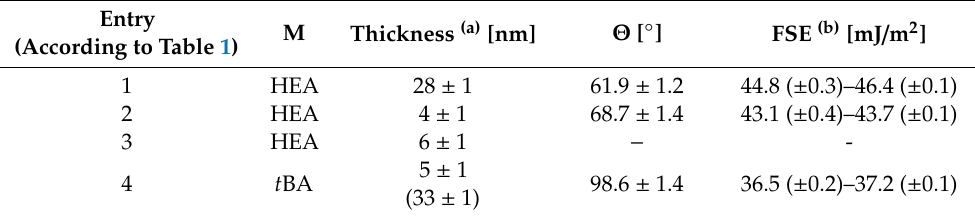
Table 2. Summary of AFM and contact angle analysis of homopolymer and block copolymer brushes grafted from the silicon surface via ultralow ppm SI- se ATRP.